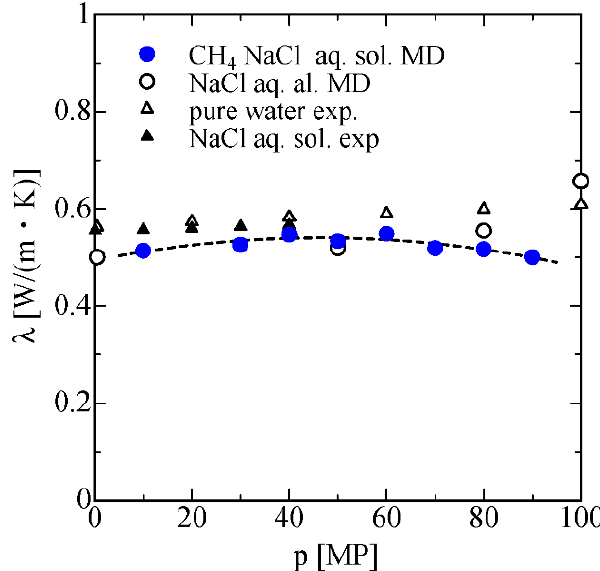
Figure 12. The pressure dependence of the thermal conductivity of CH 4 and NaCl aqueous solution, and NaCl aqueous obtained by molecular dynamics (MD), alongside the experimental data.